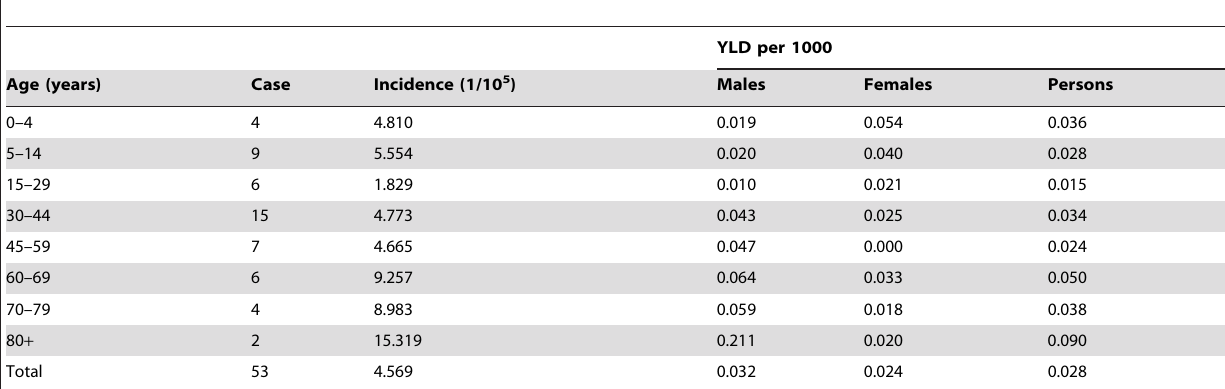
Table 2. The epidemiological burden of malaria caused by flooding alone during exposure effect-period for flooding.